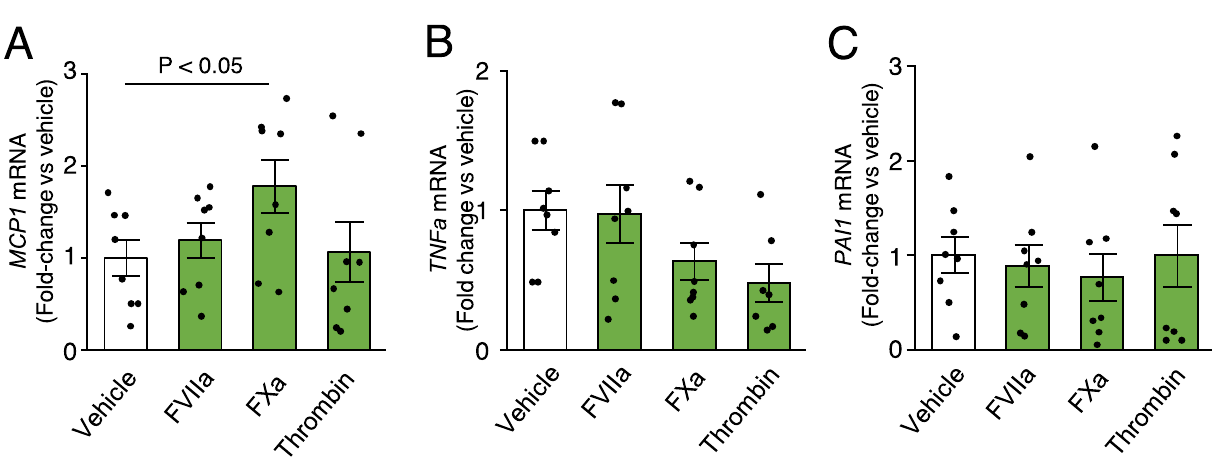
Figure 3. Effects of coagulation proteases on pro-inflammatory gene expression in THP-1 cells. ( A ) MCP1 , ( B ) TNFα , and ( C ) PAI1 mRNA levels in monocytic THP-1 cells treated with vehicle, FVIIa, FXa, and thrombin at 10 IU/mL. n =